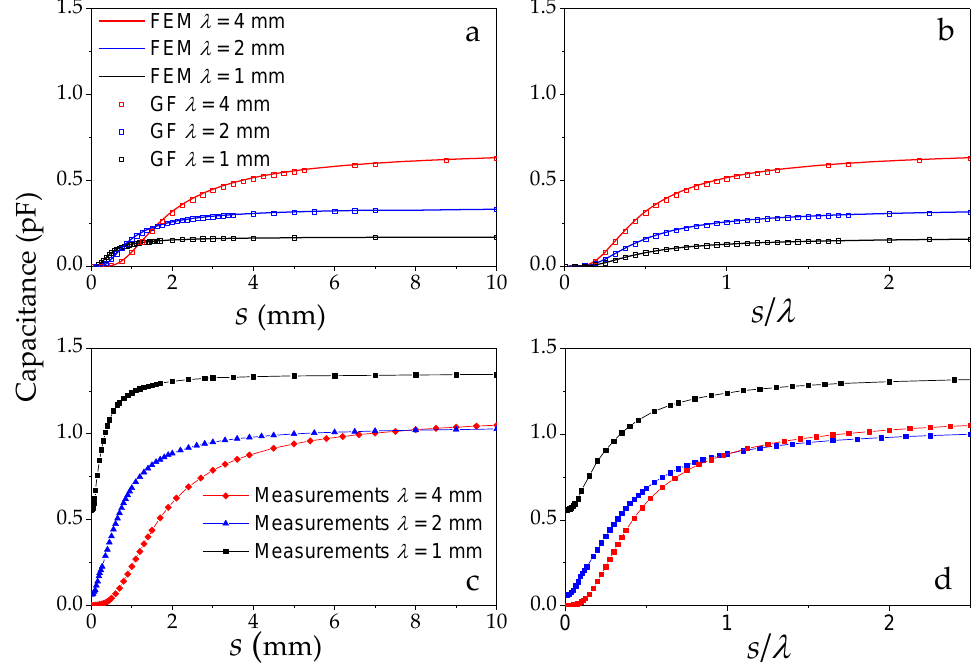
Figure 5. ( a ) Calculation of C ( s ) from (4) and agreement with FEM; ( b ) Same data plotted vs. s/ λ ; ( c ) Experimental results for three different IDS wavelengths; ( d ) Same data plotted vs. s / λ . Clearly visible is the inverted order of s / λ in the experiment due to an increased offset in the capacitance.